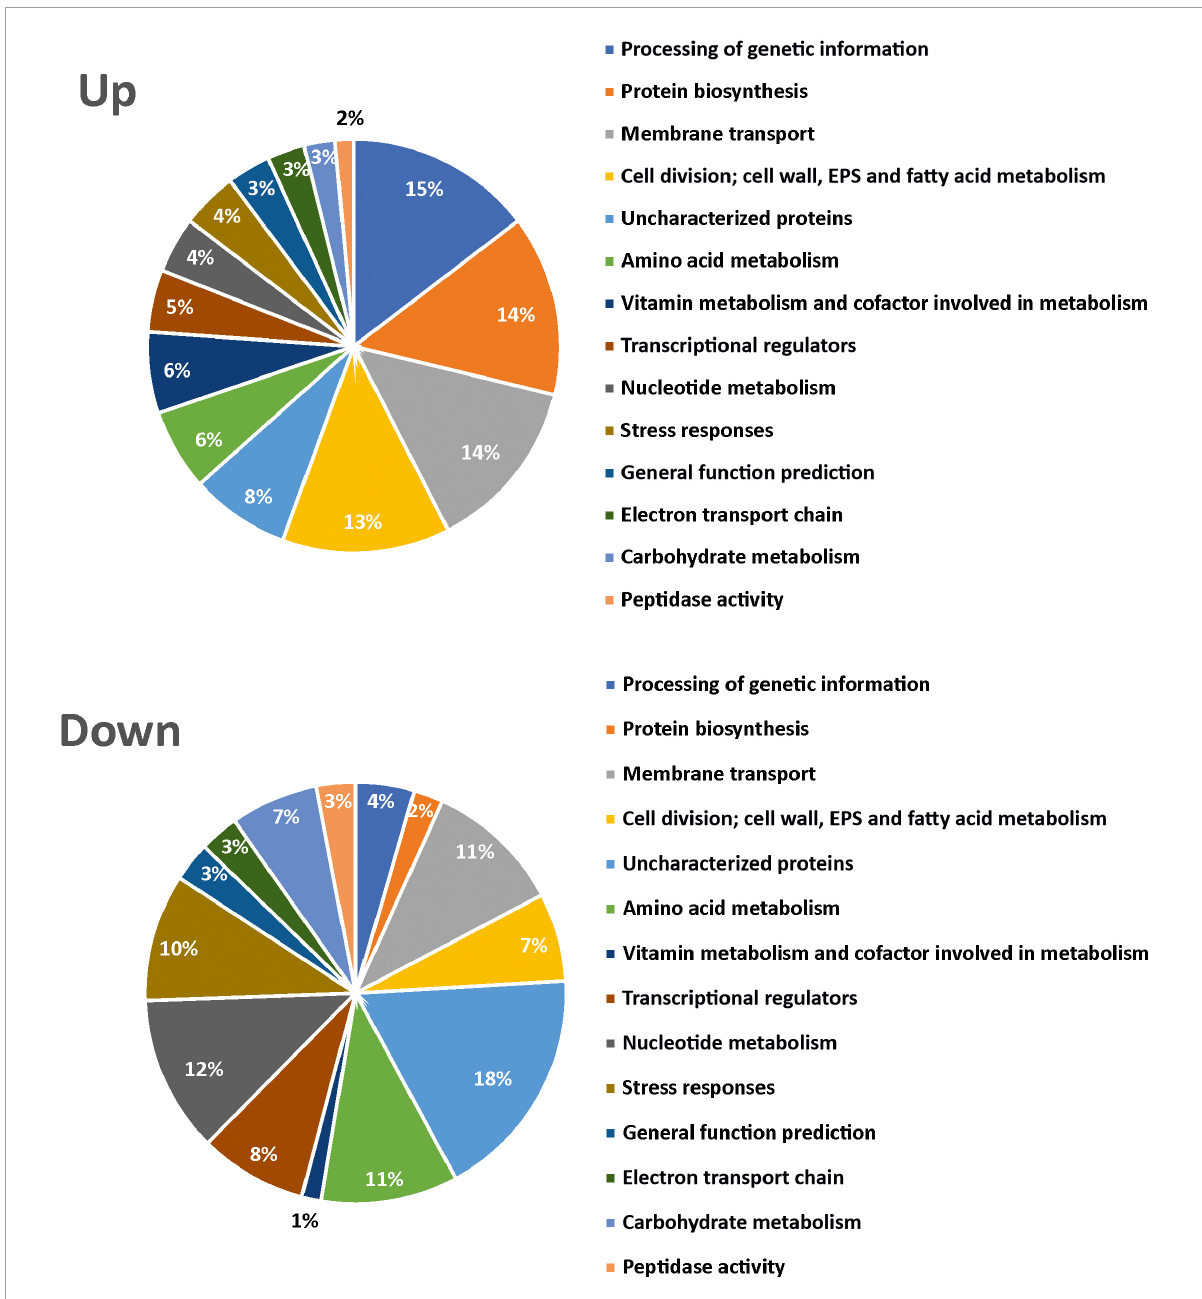
FIGURE3 Pie chart representation in Lc. lactis AV1n[pRCR21] of upregulated and downregulated proteins at 20 ◦ C vs. 37 ◦ C. Fourteen different categories and their relative percentage are depicted.